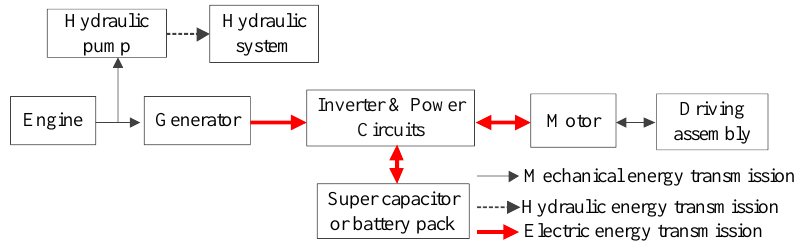
Figure 6. Typical configuration of series oil–electric hybrid system